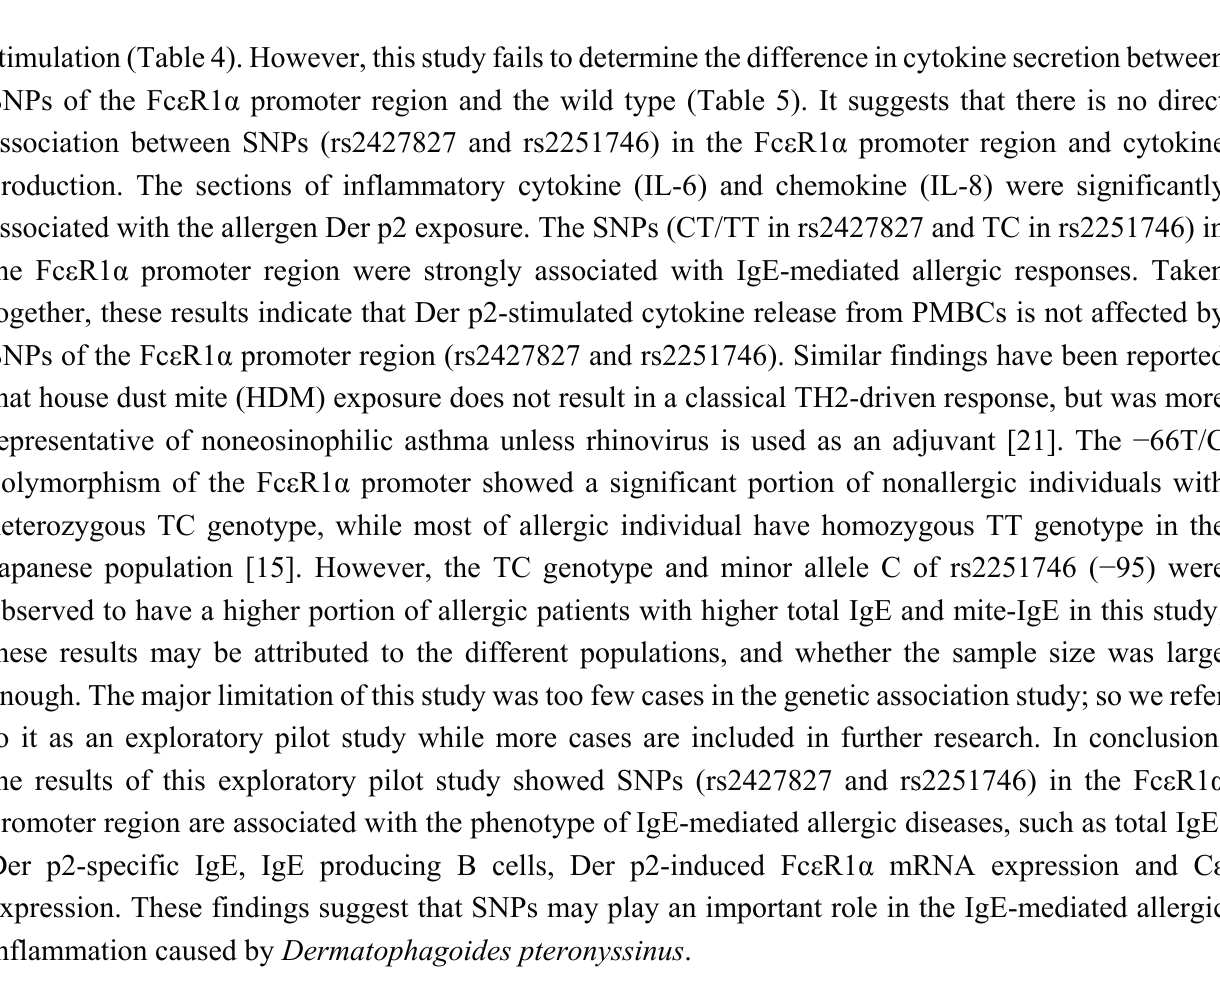
Table 5. Comparison of cytokine secretion derived from PBMC between SNPs of Fc ε R1 α promoter region and wild type.